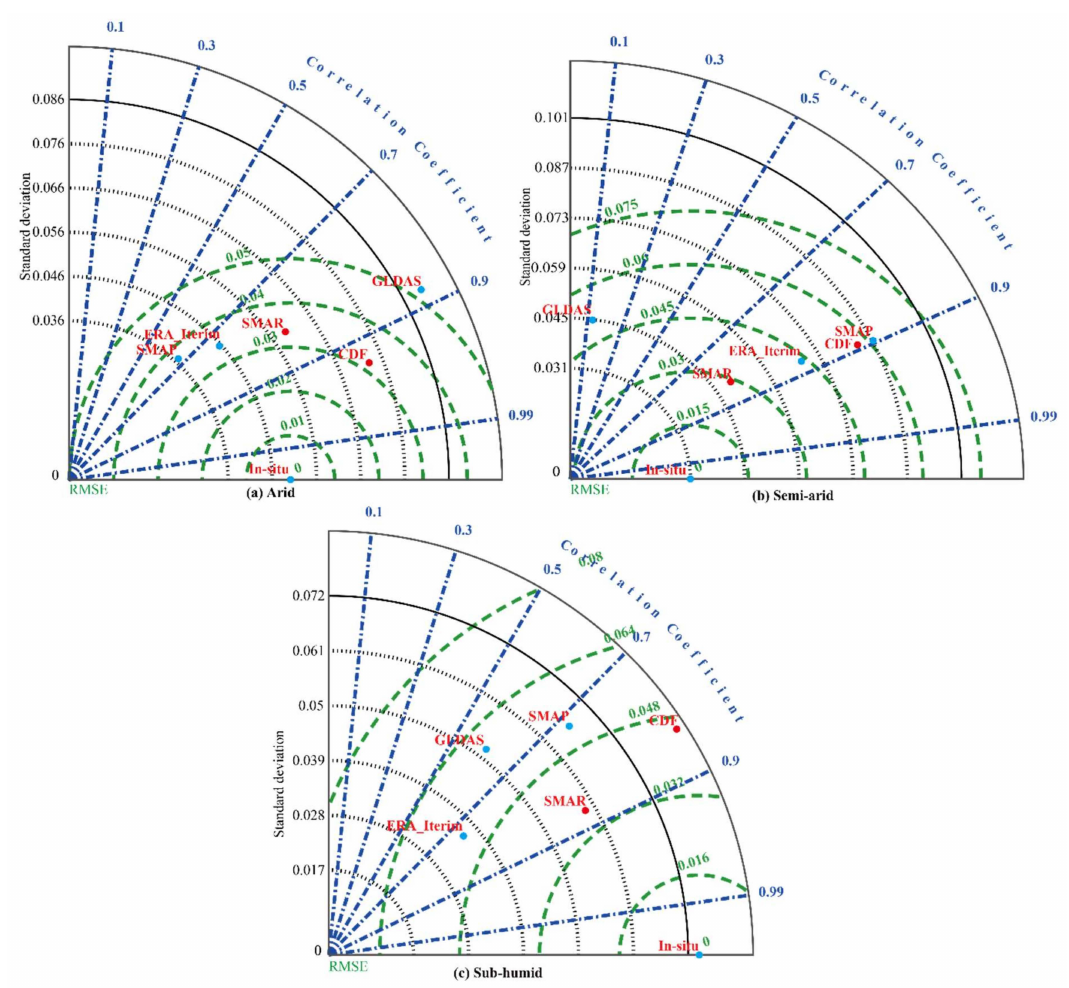
Figure 9. Taylor Diagrams of Inter-comparison between RZSM Data and Others: ( a ) Arid; ( b ) Semi-arid; and, ( c ) Sub-humid; Products name tags with red dots represents the predicted RZSM product from this research; Cyan dots represent ERA-Interim, GLDAS, and SMAP RZSM